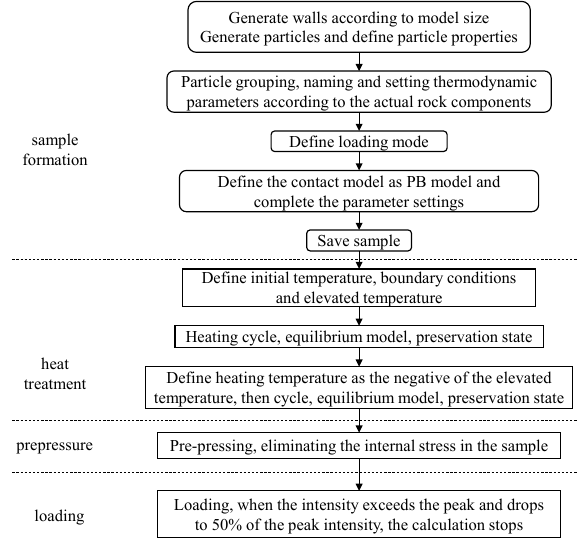
Figure 11. Flow chart of PFC simulation.